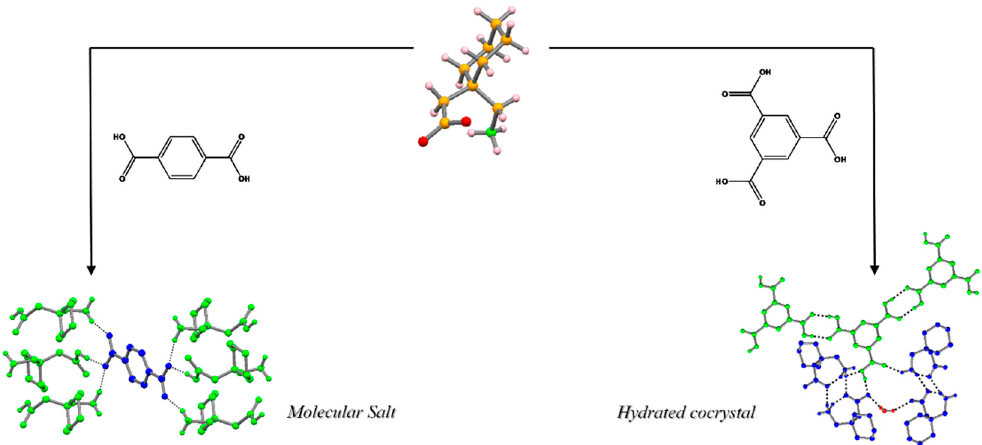
Figure 4. Schematic representation of the new multicomponent crystal forms of gabapentin with terephthalic and trimesic acids [45].